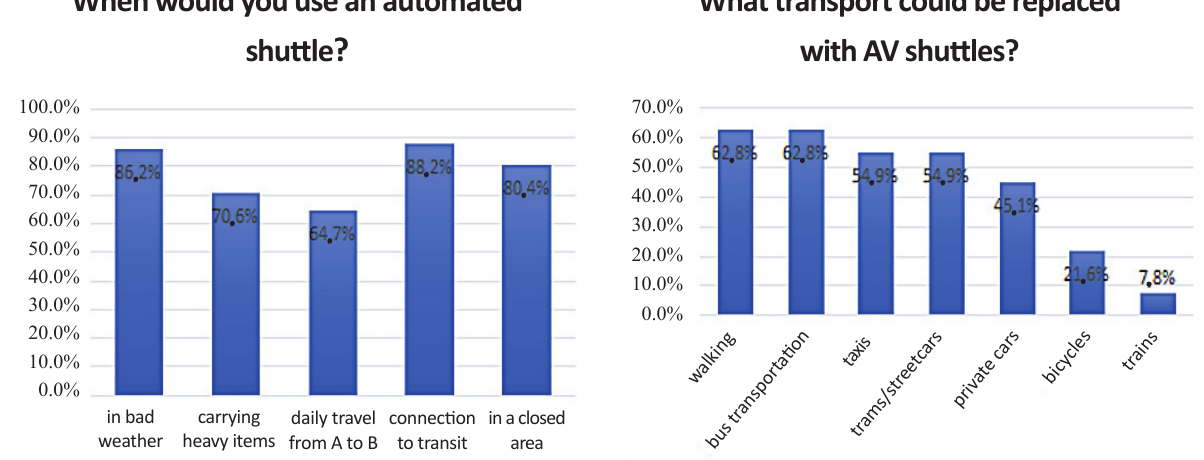
Fig. 5. Survey results on passengers’ estimations of AV